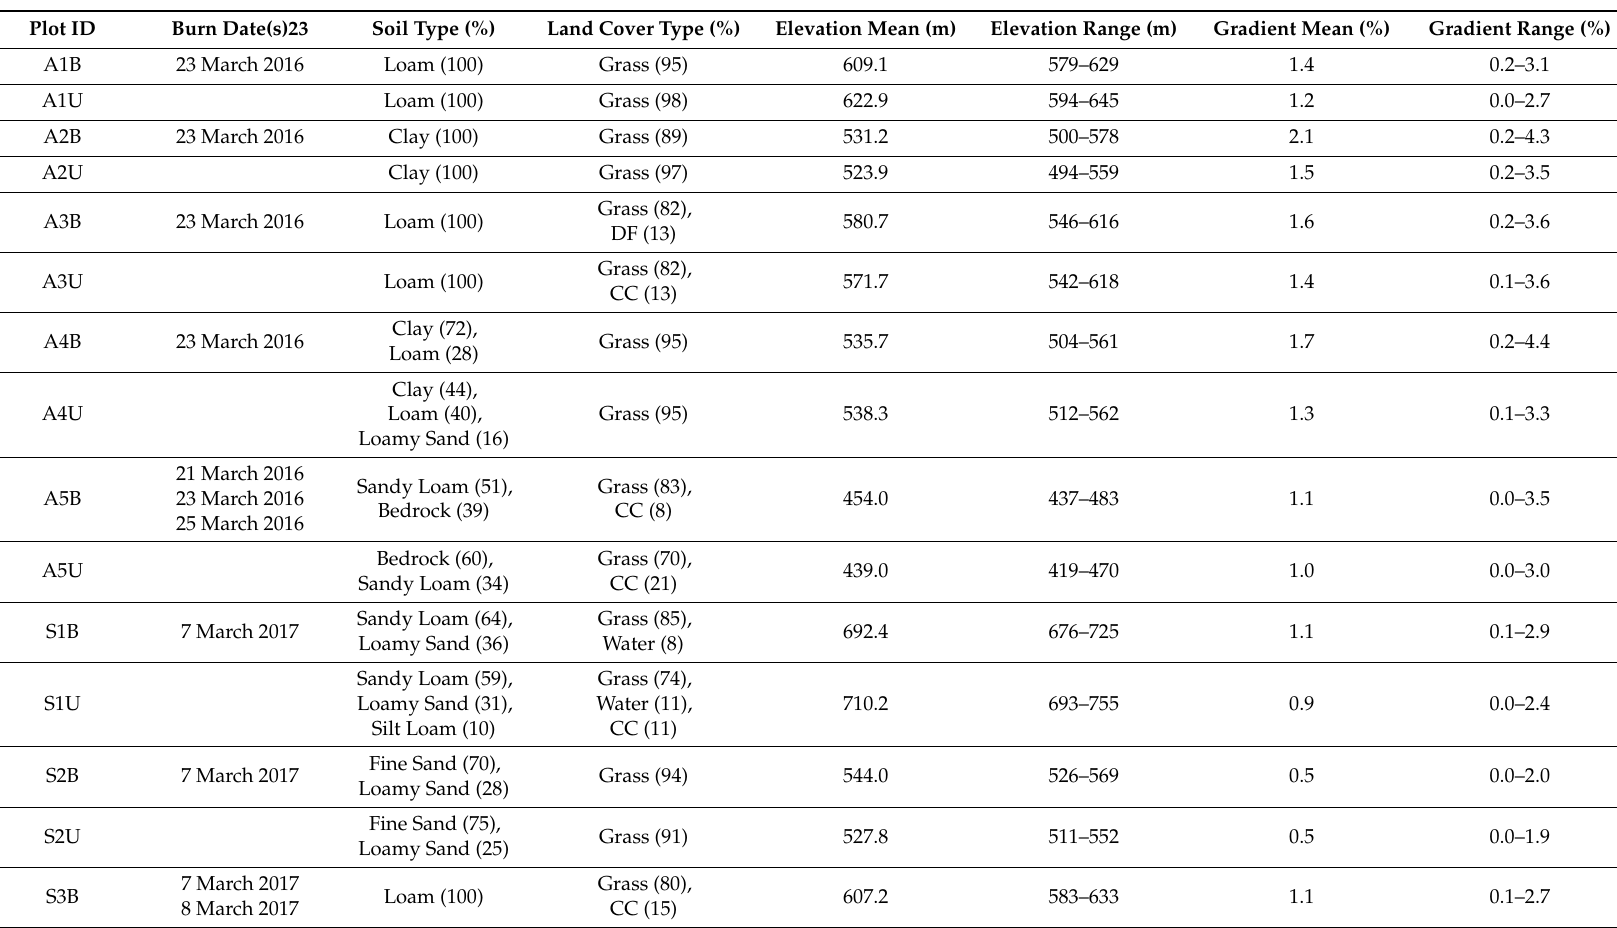
Table A1. Characteristics of paired burned (B) and unburned (U) plots for the Anderson (A), Starbuck (S), and Perryton (P) fires in western Kansas, Oklahoma, and Texas. Pairs were delineated based on similarity of soil type, land cover type, elevation, and